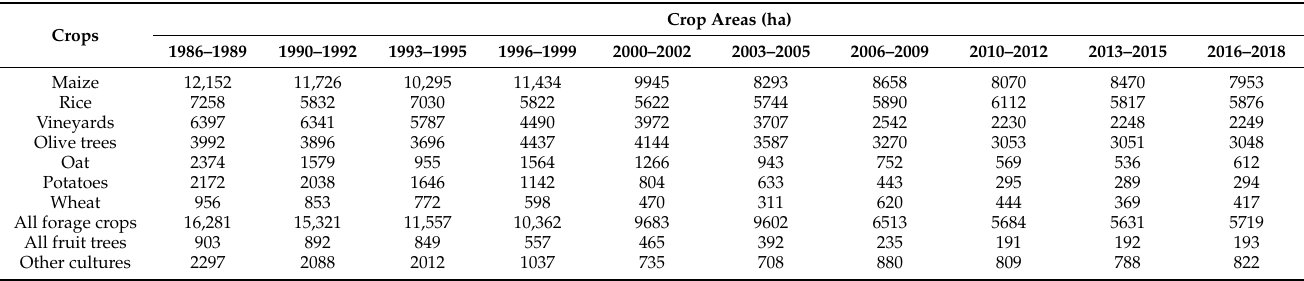
Table 1. Areas dedicated to different crops in Low